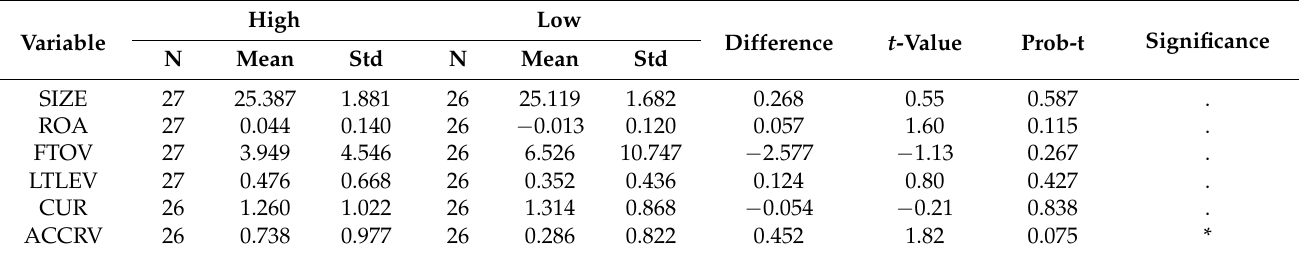
Table 4. The mean difference of TF/IDF of PT perspective between high (1,2) and low (4,5) quintile.